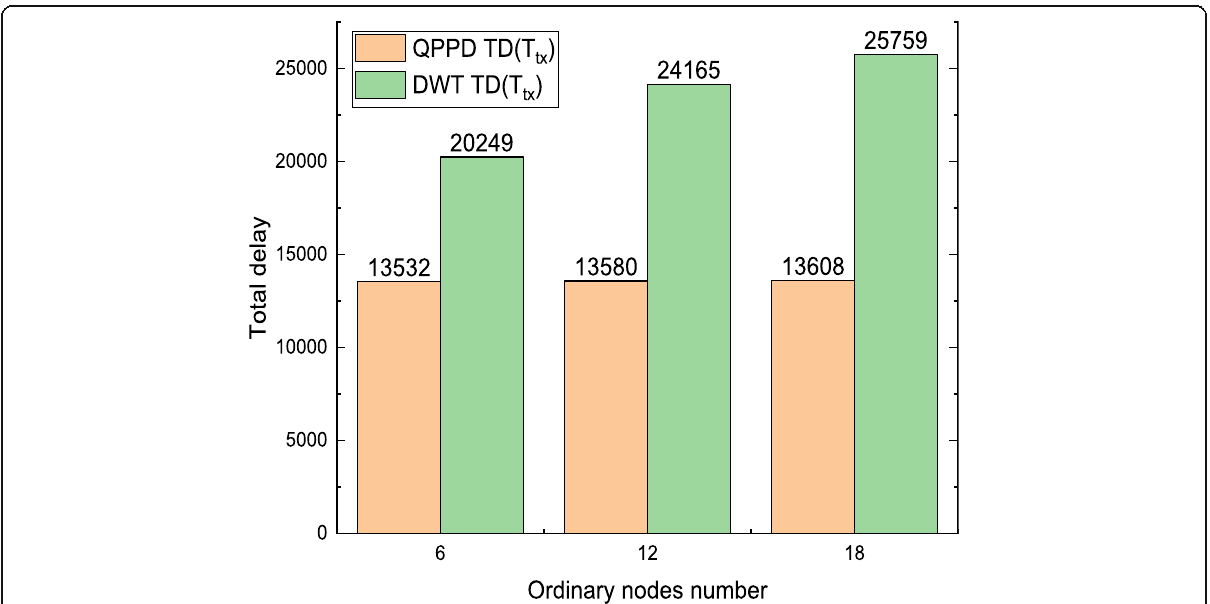
Fig. 18 The total number of periodic data changes increases from 0 to 12; the total